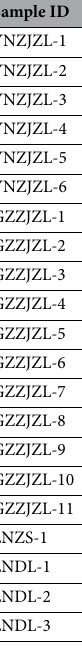
Table 1. Sample ID of Crofton weed, Purple Perilla &